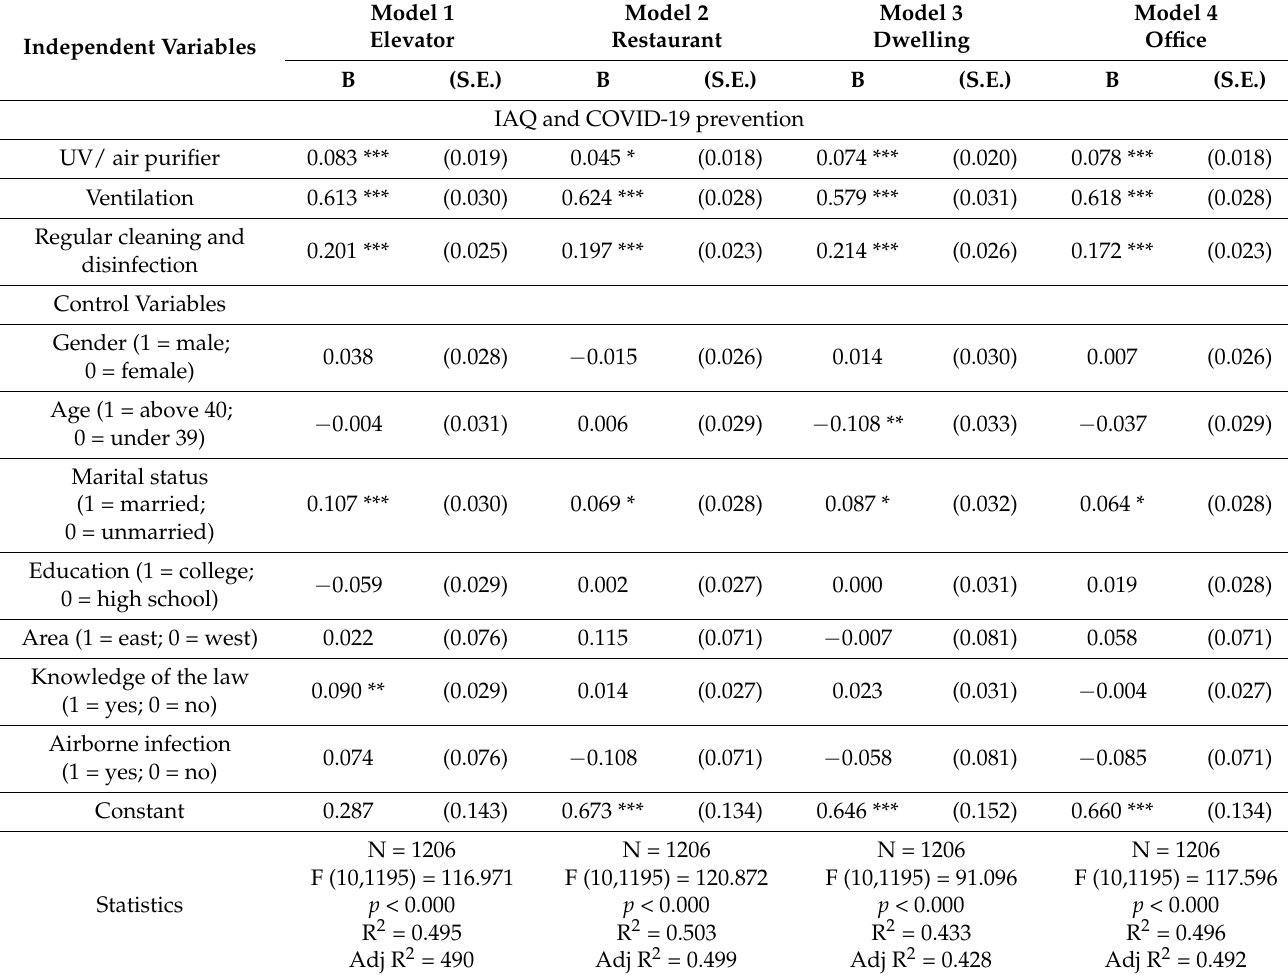
Table 8. The IAQ and COVID-19 prevention regression (four cases).